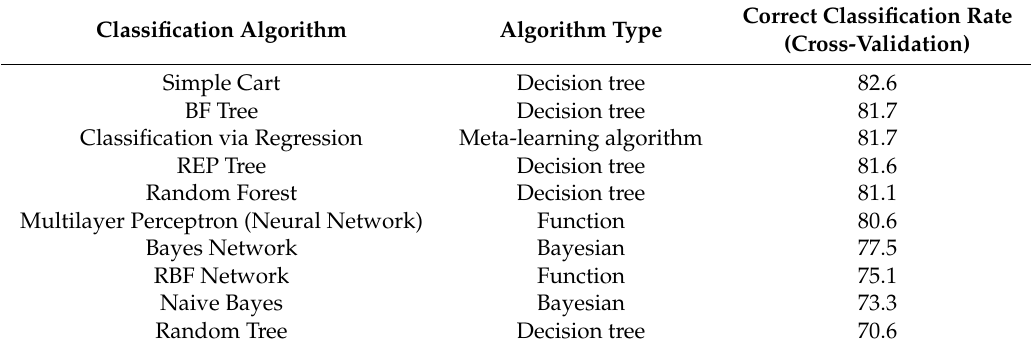
Table 3. Classifiers tested for the case study with their rates of correct classification on drill hole data.